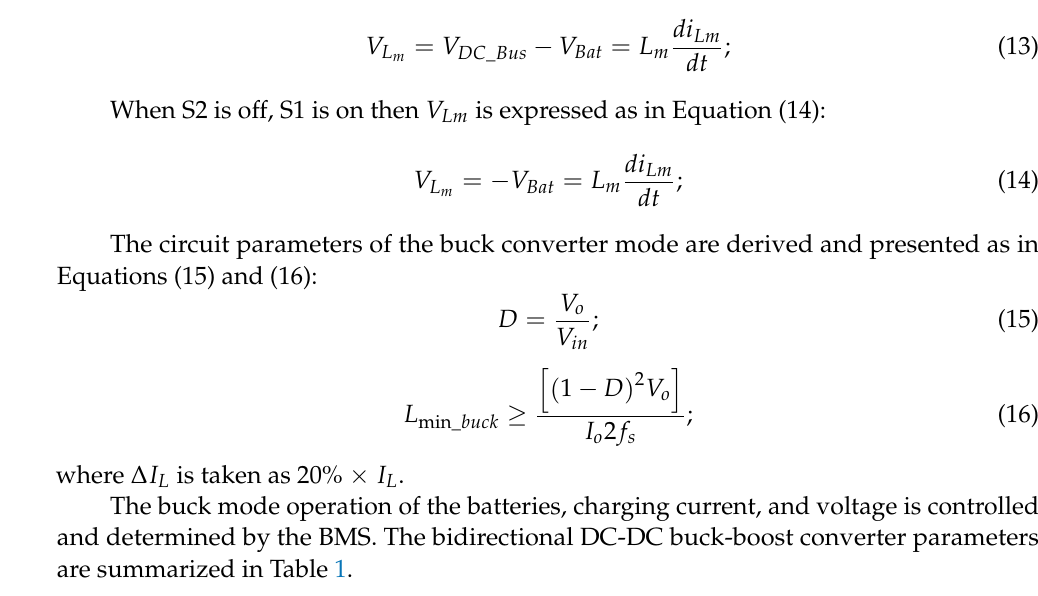
Table 1. Designed parameters of bidirectional buck-boost converter for